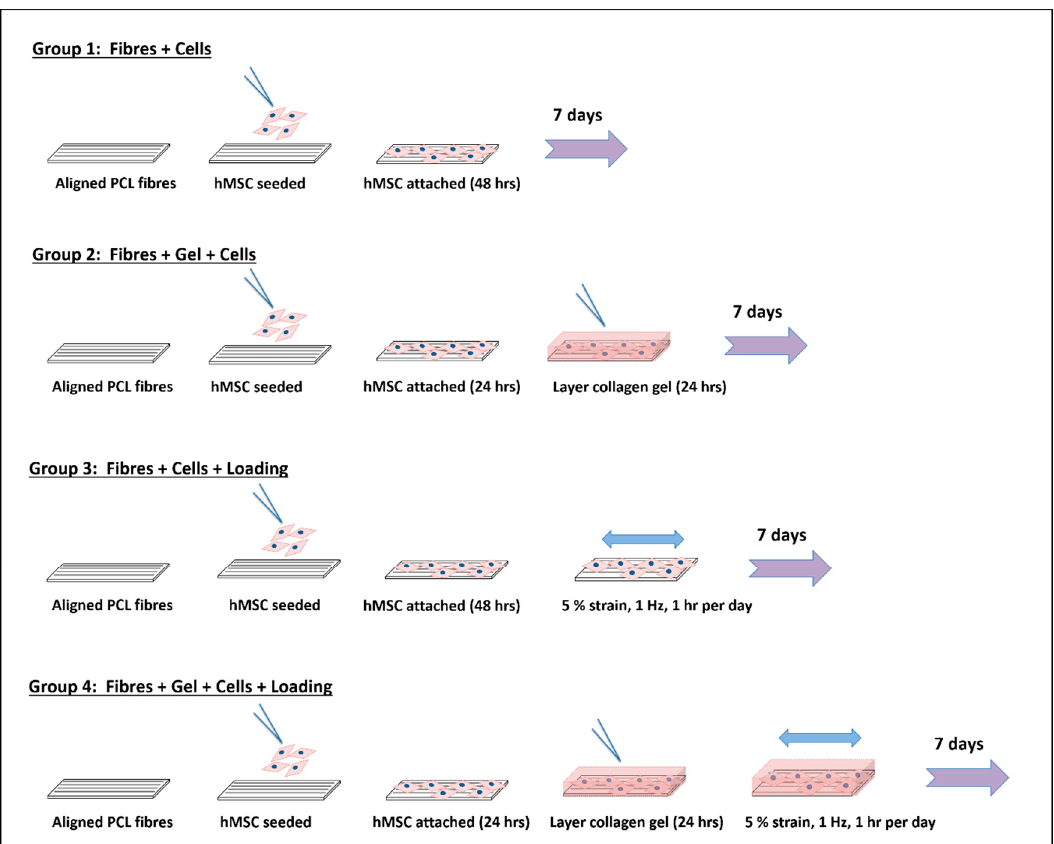
Figure 2. Schematic of experimental set up for four test groups seeded with human mesenchymal stem cells (hMSC).